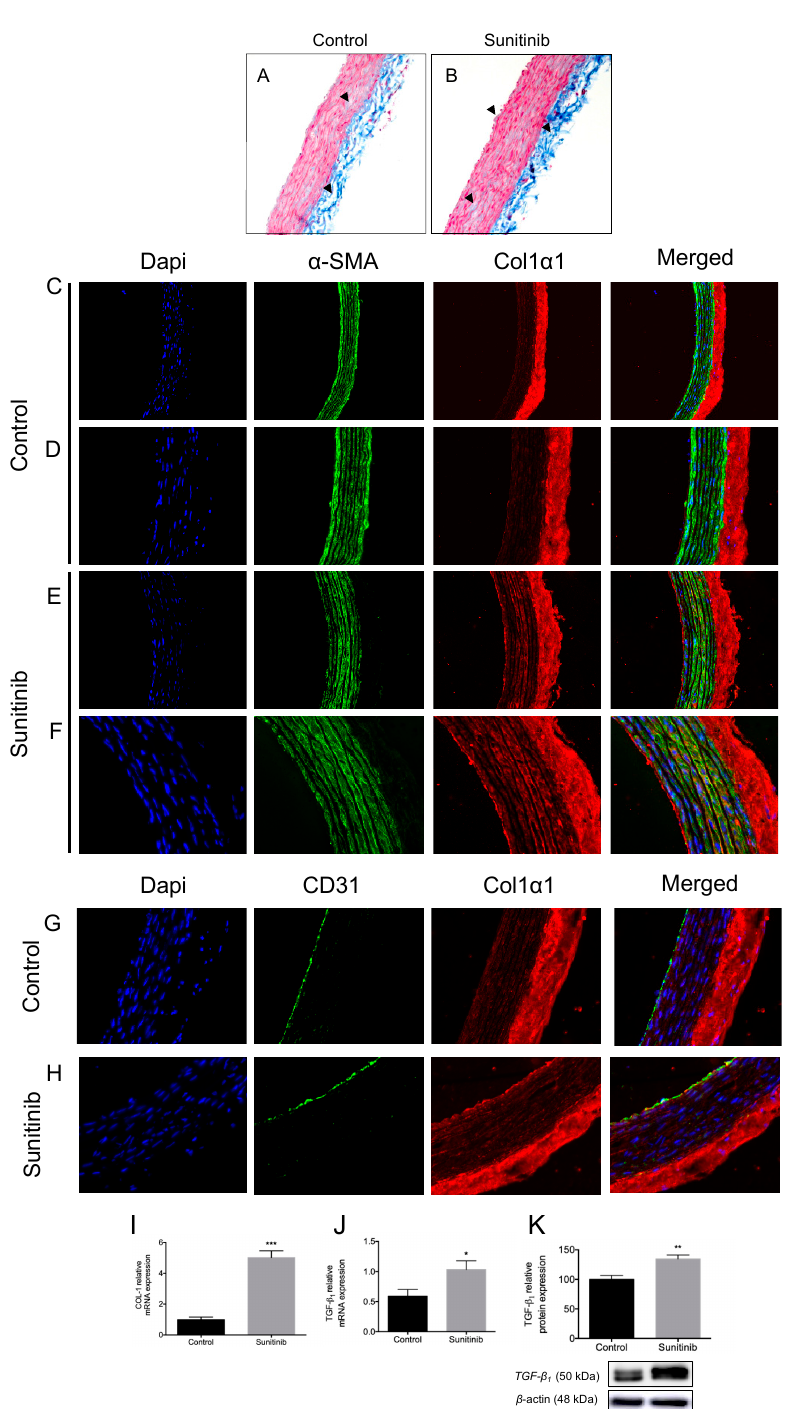
Figure 4. Masson’s trichrome staining for collagen fibers in blue ( A , B , marked with arrowheads), double immunostaining of collagen 1 alpha 1 (Col1 α 1) (red) and α -smooth muscle actin ( α -SMA) from vascular smooth muscle cells (VSMCs) (green) ( C – F ), and Col1 α 1 (red) and CD31 (green) ( G , H ), and protein / mRNA expression of Col1 ( I ) and TGF- β 1 ( J , K ), in aortas from control and sunitinib-treated (25 mg / kg / day) animals. Magnification 10 × for Masson’s trichrome staining. Magnifications: 10 × ( A , B ), 20 × ( C , E ) and 40 × ( D , F – H ). Values are expressed as mean ± S.E.M. of at least 6 animals per group ( n = 6–8). * p < 0.05; ** p < 0.01; *** p < 0.001 vs. control